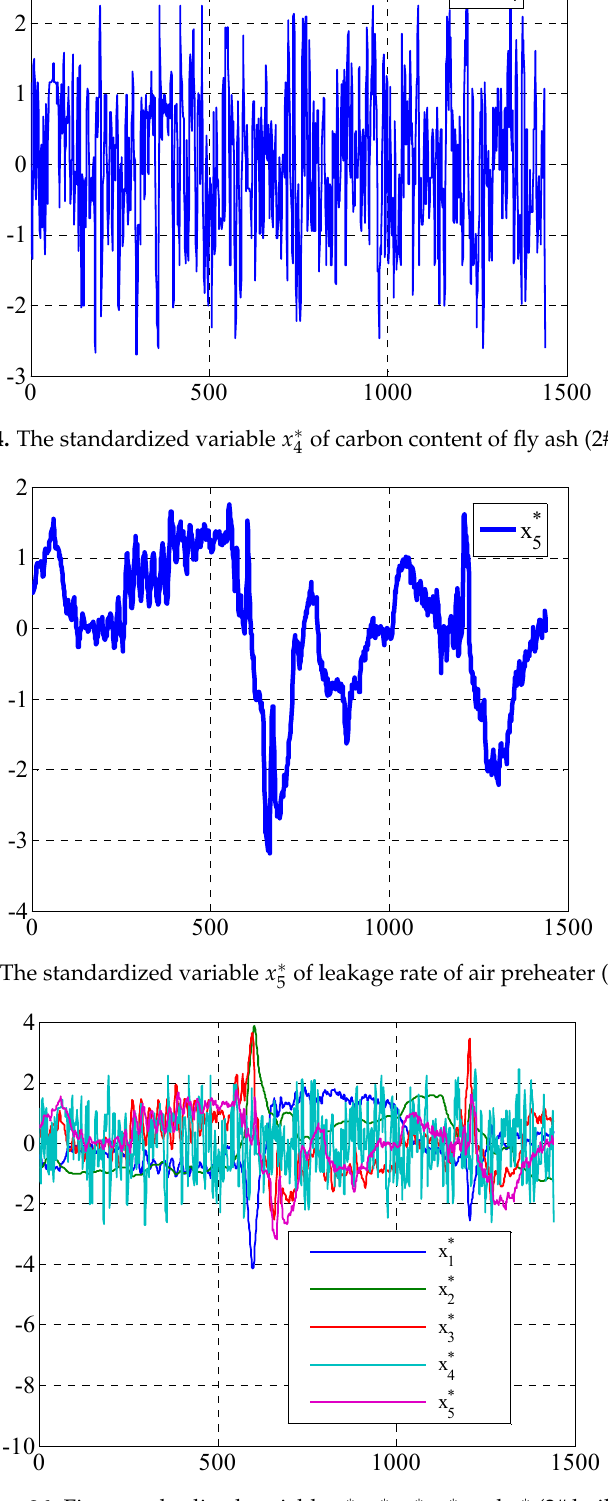
, x ∗ , x ∗ , x ∗ and x ∗ (2# 2 3 5 1 4